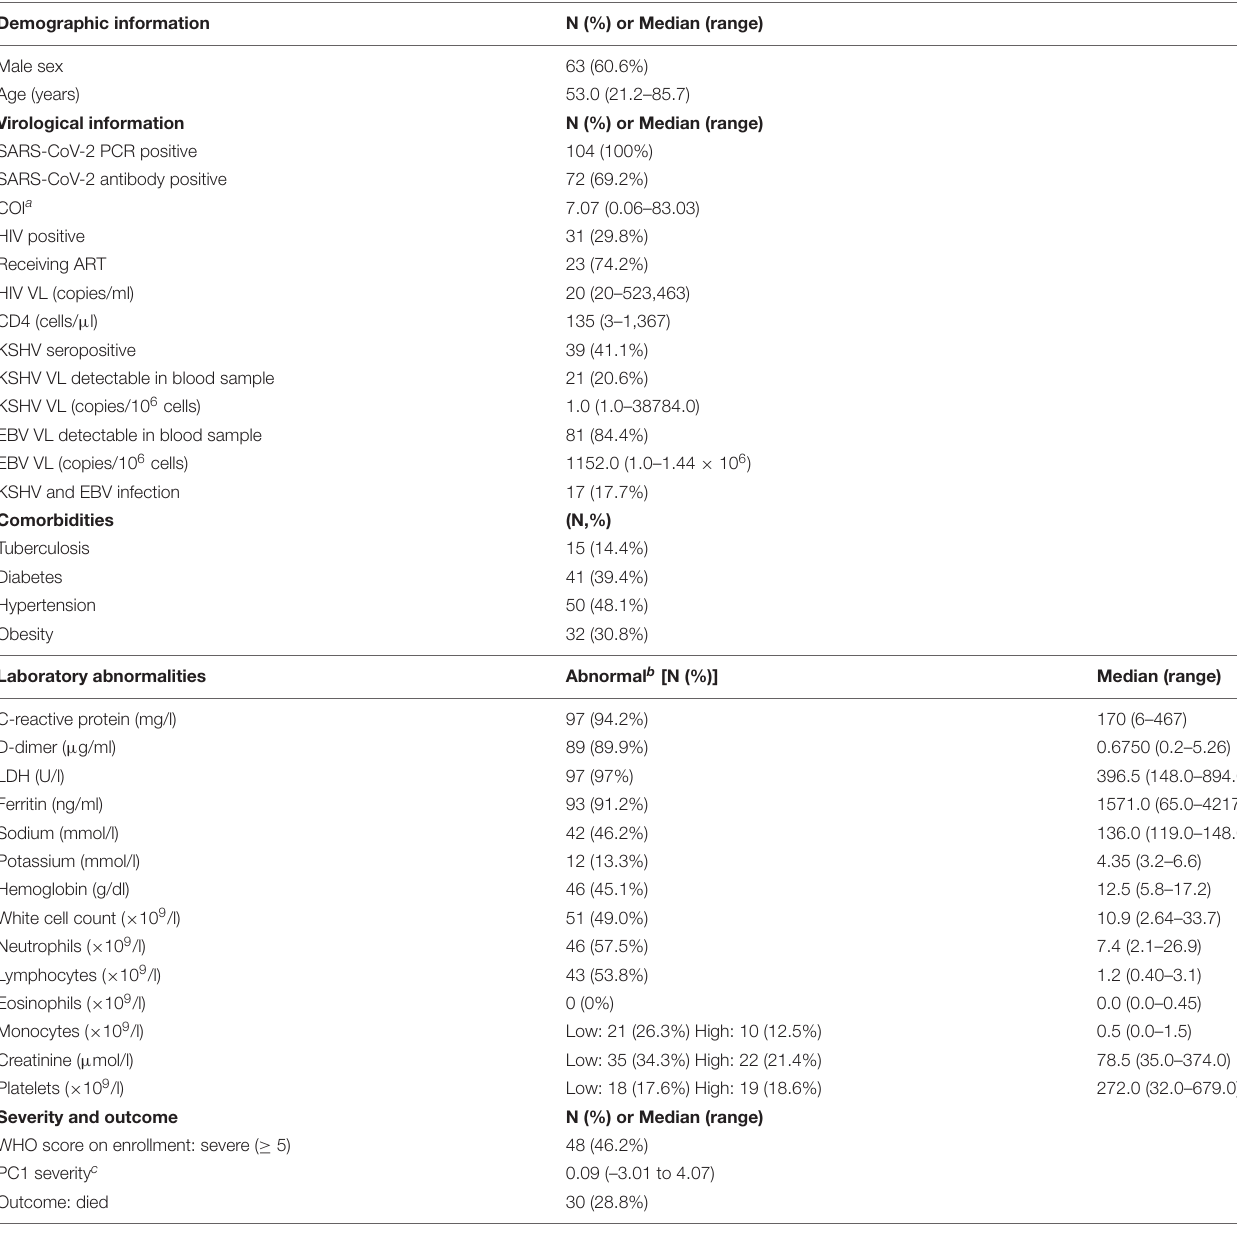
TABLE 1 | Baseline characteristics of COVID-19 patients ( n =